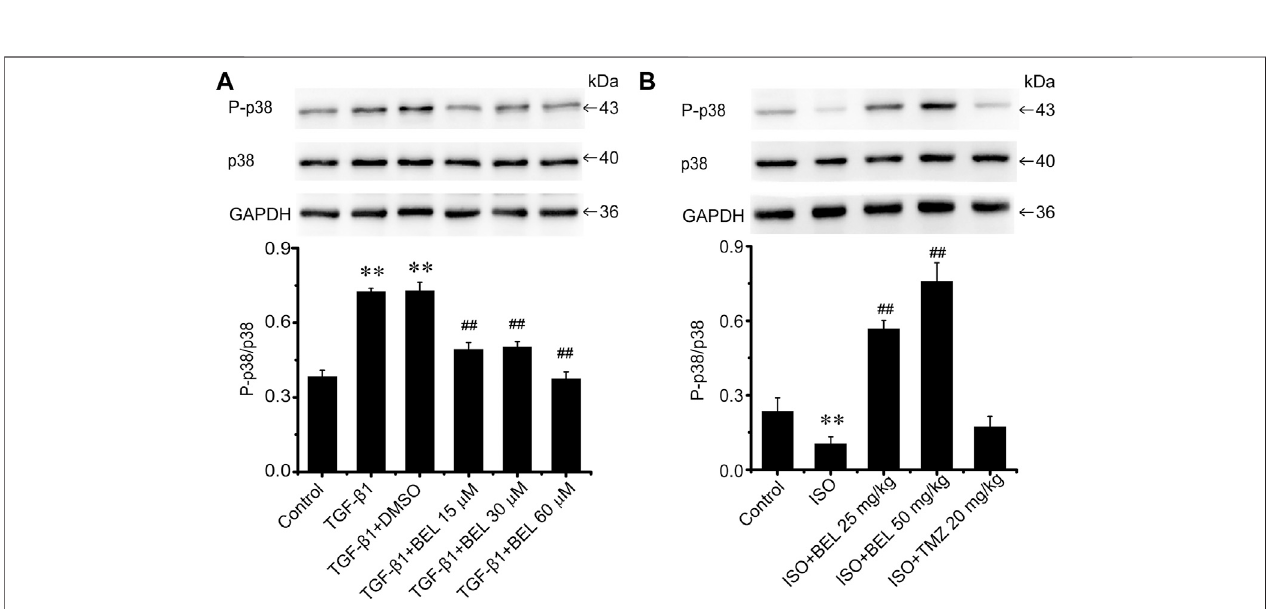
FIGURE 9 | The effects of BEL on p38 signaling in vitro and in vivo (A) The effects of different doses of BEL (15, 30, 60 μ M) on the expression p38 and the level of P-p38 in CFs induced by TGF- β 1 using western blotting. Bar graphs show fold changes of P-p38/p38 ( n (cid:2) 3). Data were shown as mean ± SEM. ** p < 0.01 vs. control, ## p < 0.01vs.TGF- β 1 (B) TheeffectsofBELontheexpressionp38andthelevelofP-p38 invivo bywesternblotting.BargraphsshowfoldchangesofP-p38/p38( n (cid:2) 3). Data were shown as mean ± SEM. ** p < 0.01 vs. control, ## p < 0.01 vs. ISO.